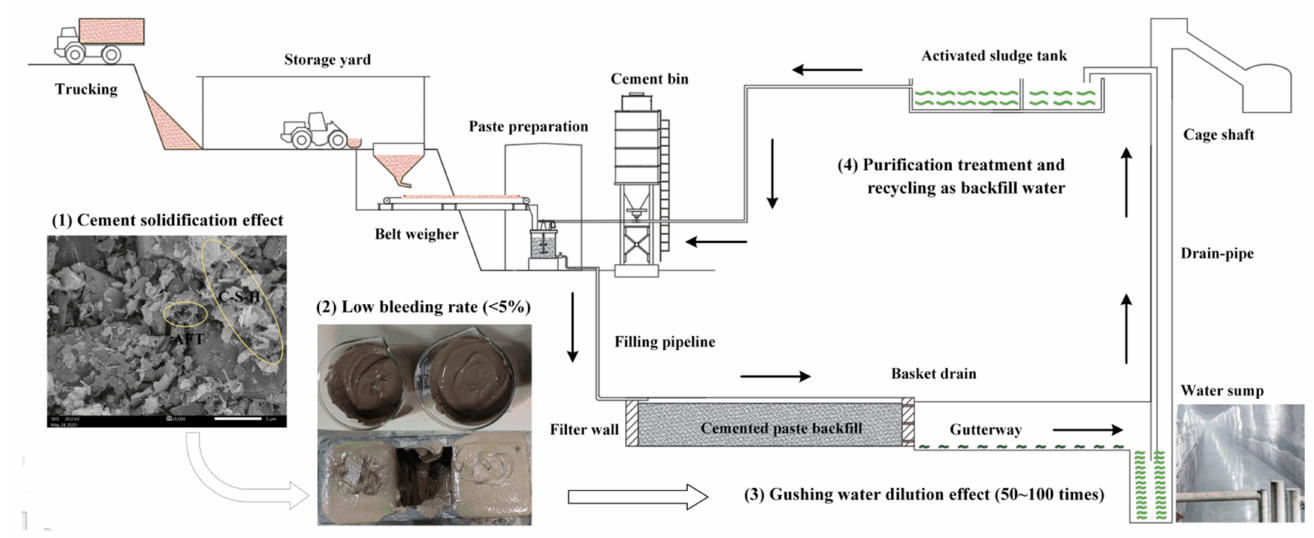
Figure 5. Backfilling technology of RMCB and groundwater recycling